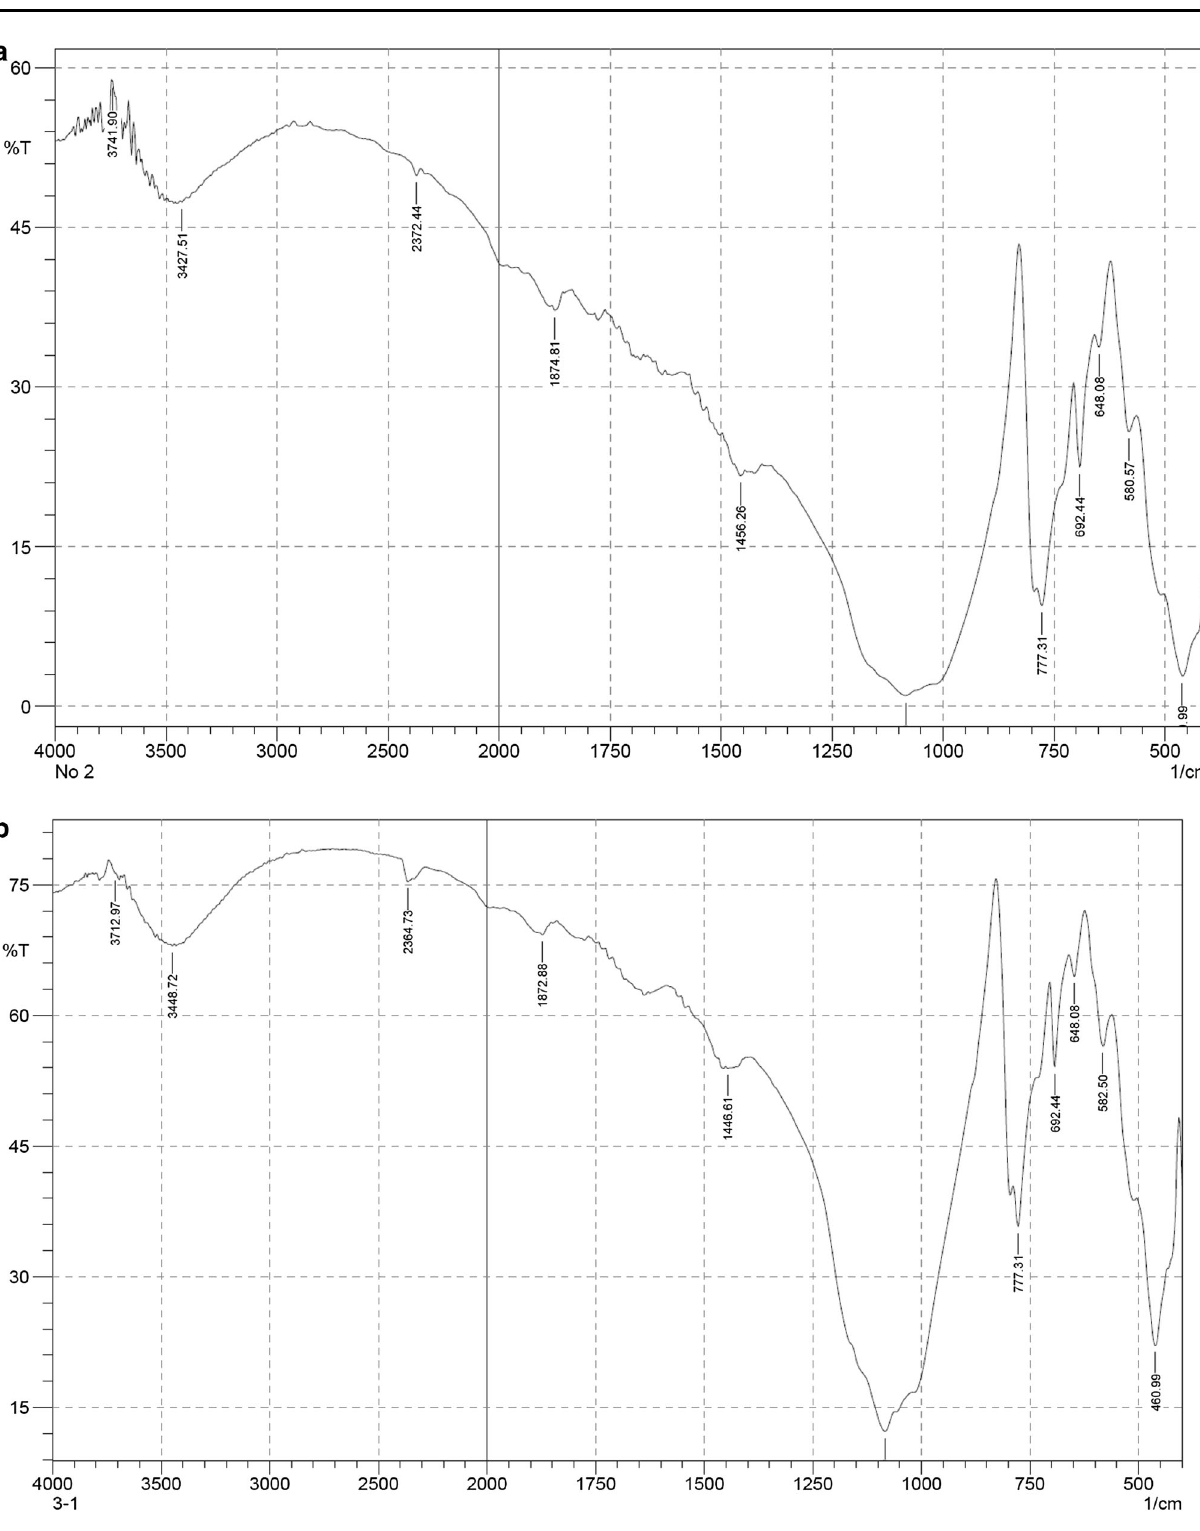
Fig. 6 FTIR spectrum a fresh sand, b MOCP C-sand and c Moringa